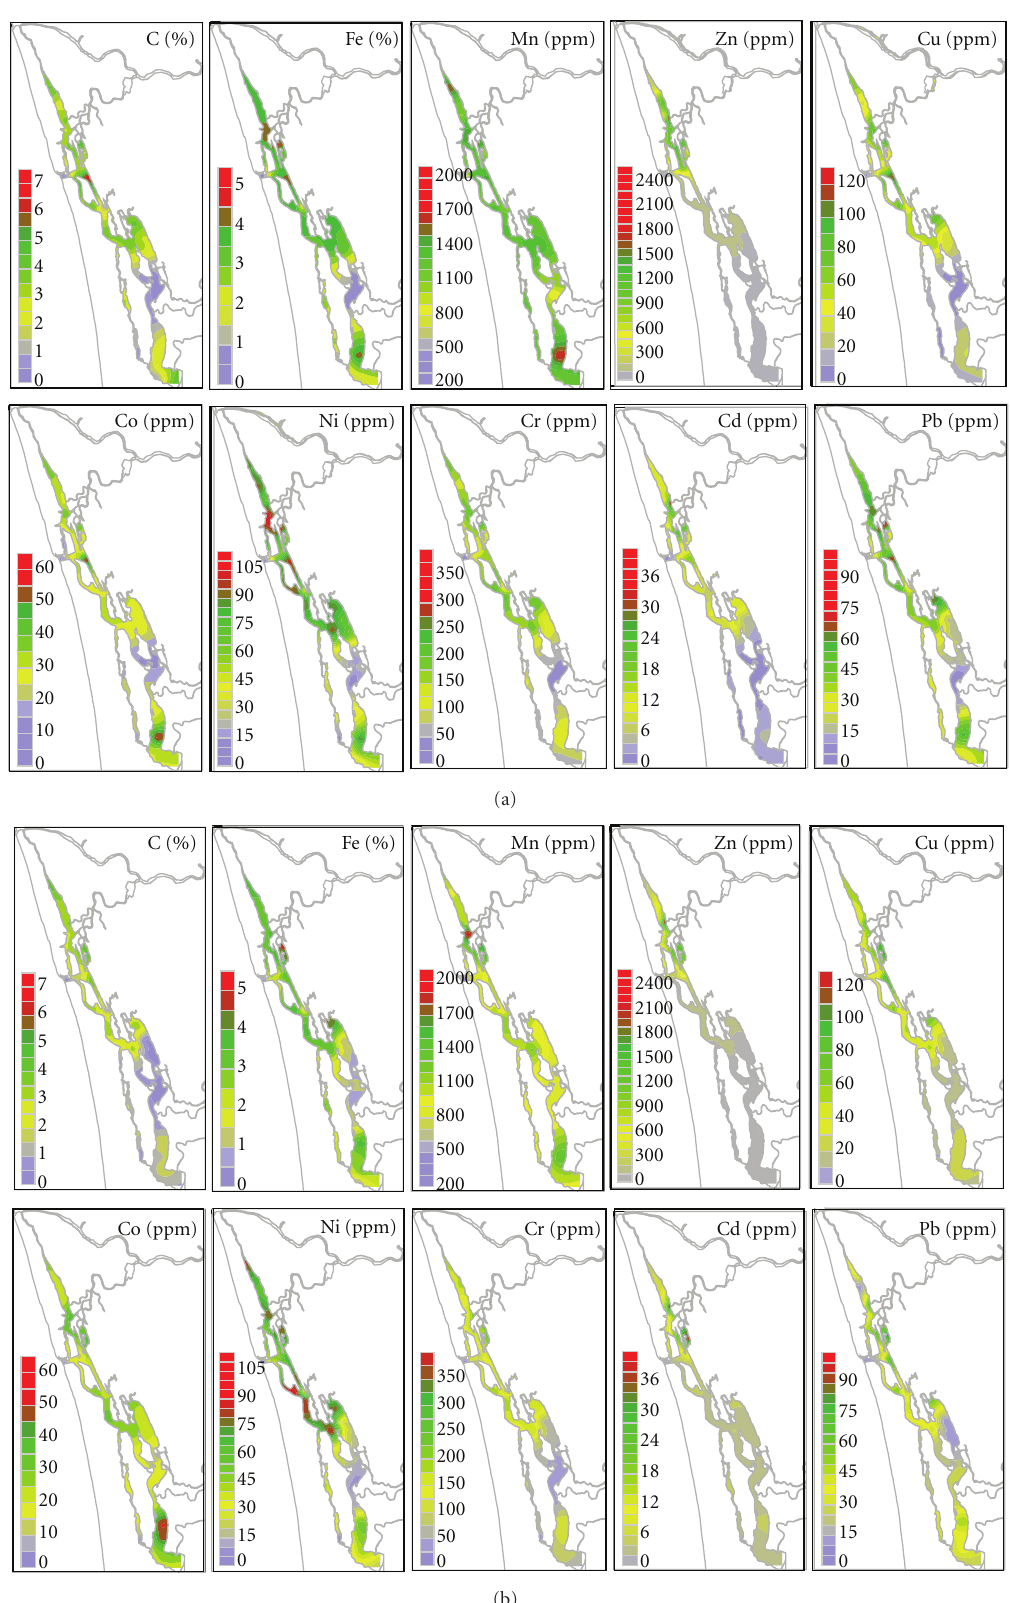
Figure 3: (a) Organic carbon and trace metal distribution during monsoon. (b) Organic carbon and trace metal distribution during